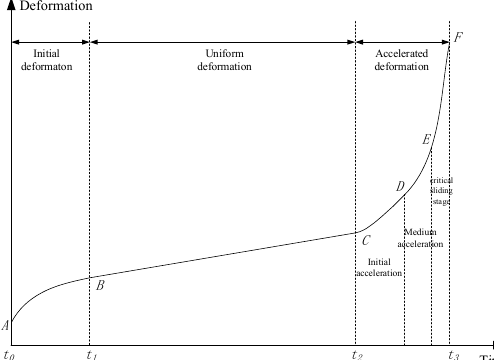
Figure 11. Different characteristics for evolution of slope deformation based on monitoring data analysis.